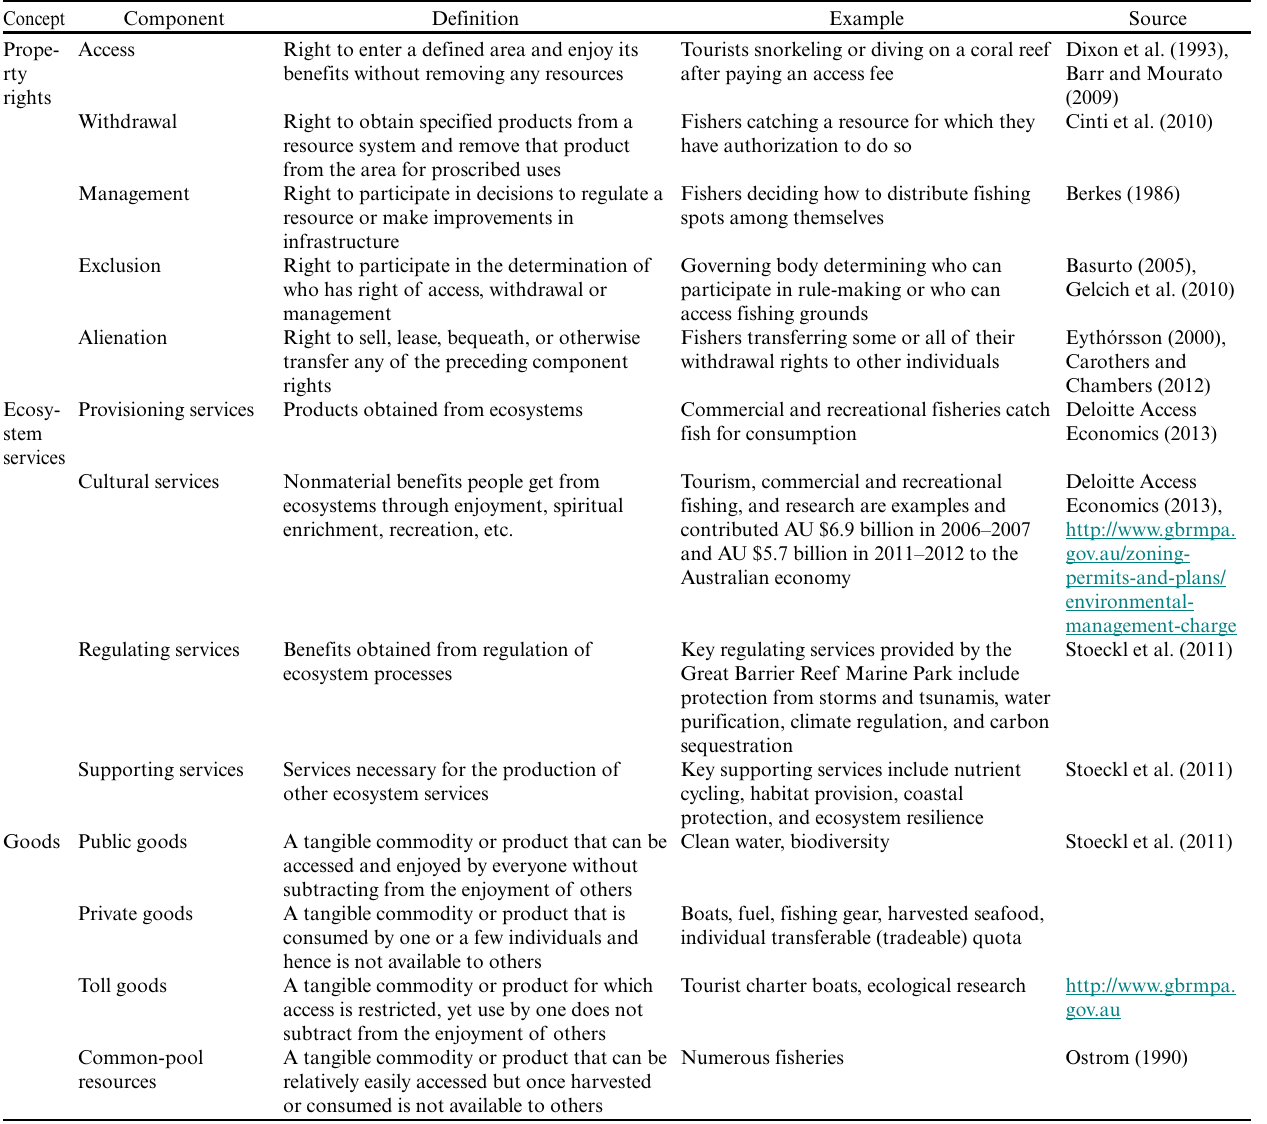
Table 1. Definitions of key components of property rights components, ecosystem services, and goods, with examples. Based on McGinnis (2011) for property rights, Millennium Ecosystem Assessment (2005) for ecosystem services, and Ostrom and Ostrom (1977) for